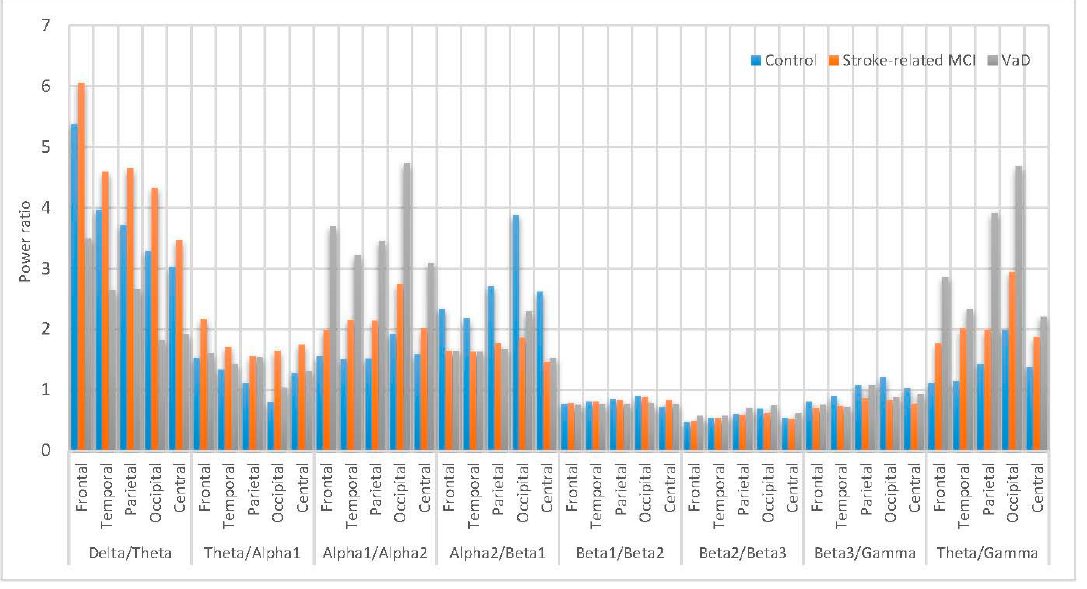
Figure 14. Comparative plot of the power ratios for the scalp regions for VaD, Stroke related MCI patients and control subjects.